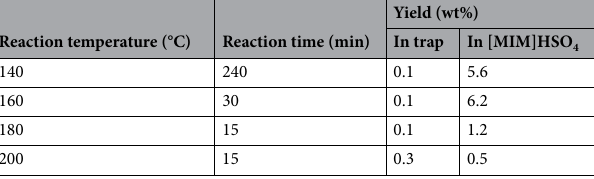
Table 3. Yields of recovered 5-HMF derived from wood (0.09 g; moisture content 4.8%) by vacuum distillation with [MIM]HSO 4 (3 g) at 2.5 kPa.